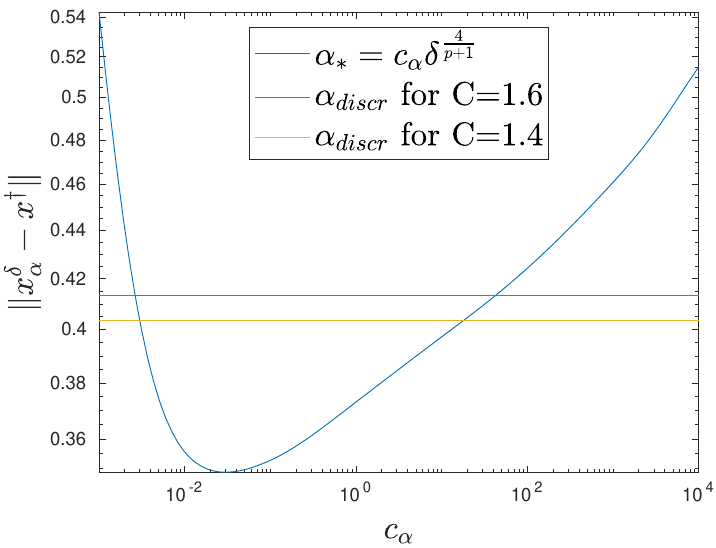
Figure 4. Regularization error (cid:107) x δ α − x † (cid:107) X using the a priori rate expressed in Equation (19) implemented in the sense of Equation (37) depending on various constants c α . Comparison with the error occurring for the discrepancy principle with C = 1.4 (orange) or C = 1.6 (red) and with noise level δ = 10 − 2.5